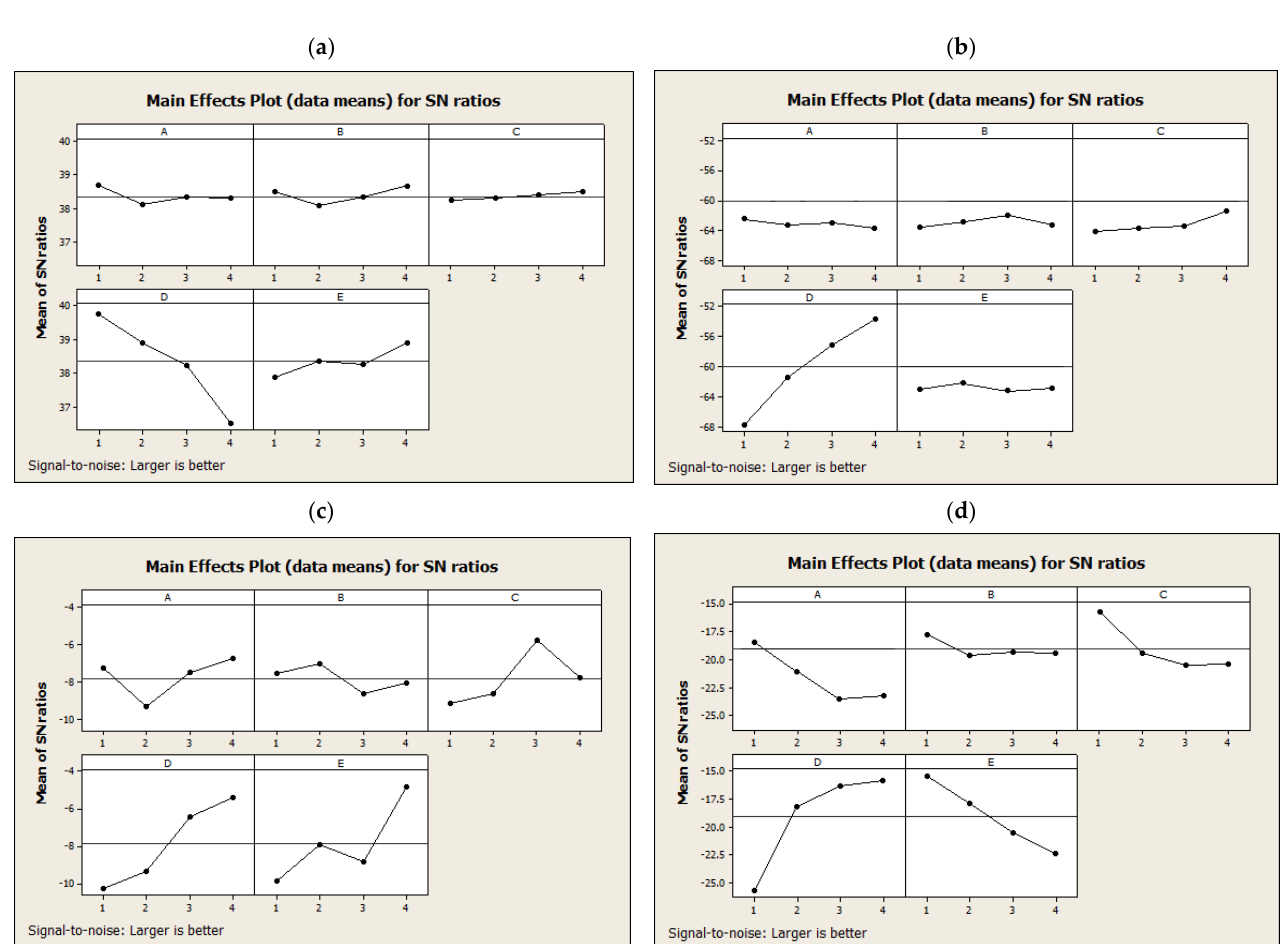
Figure 4. The larger-the-better for various outcome data are obtained from Taguchi analysis. ( a ) E F ; ( b ) R A ; ( c ) K G a ; ( d ) φ . Table 6. Optimum conditions and importance of parameters.